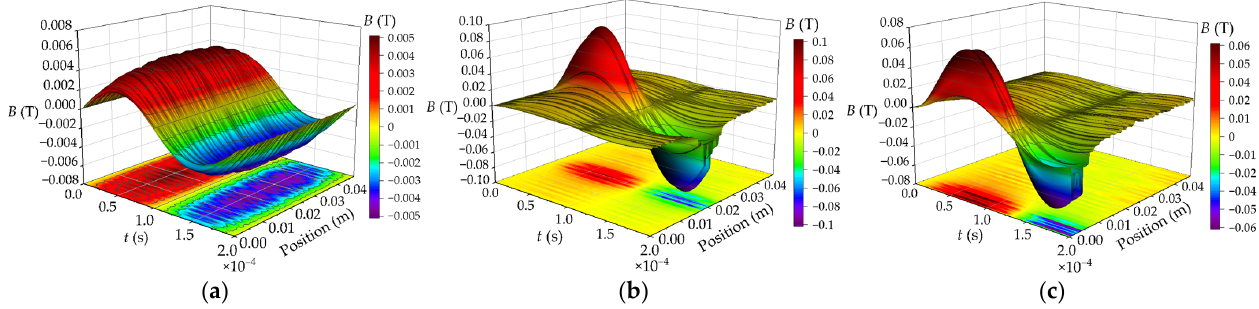
Figure 8. Comparison of axial magnetic flux leakage distribution of interleaved winding ( a ) Normal condition; ( b ) Middle-winding short circuit; ( c ) End-winding short circuit.